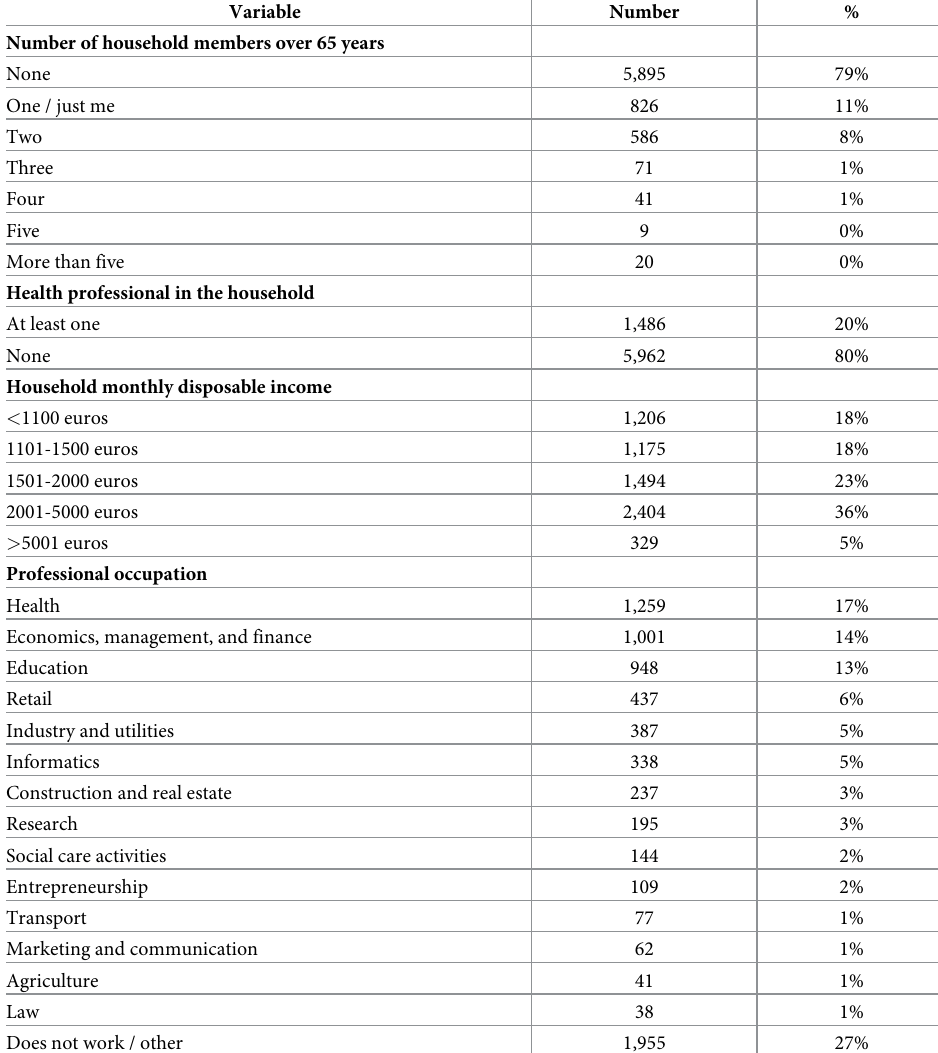
Table 3. Additional sample characterization—Household, income, and